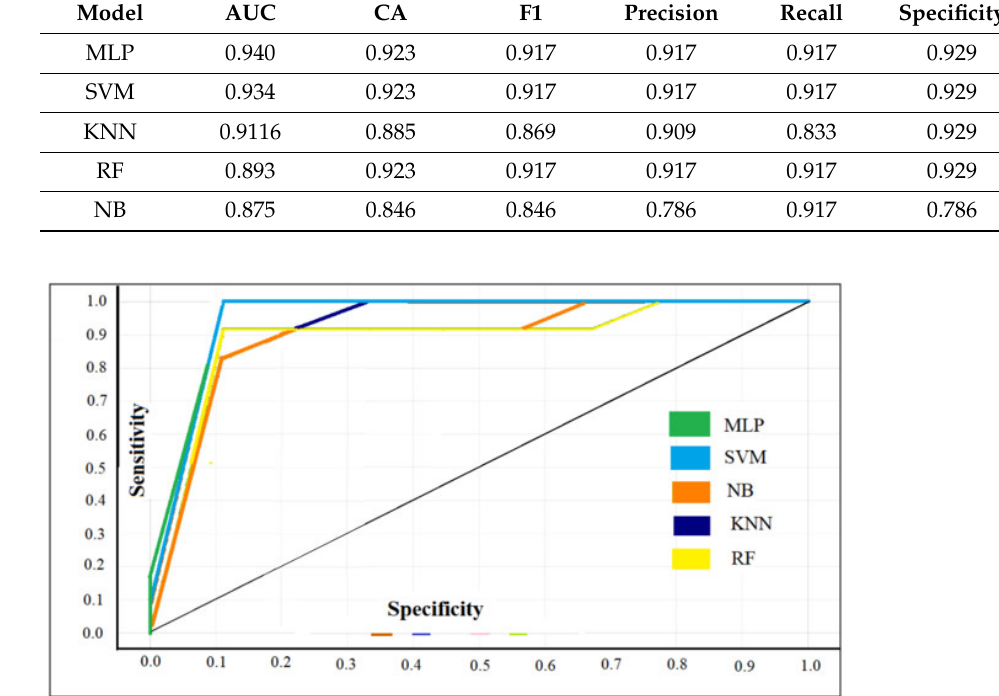
Table 4. Trained model evaluation.